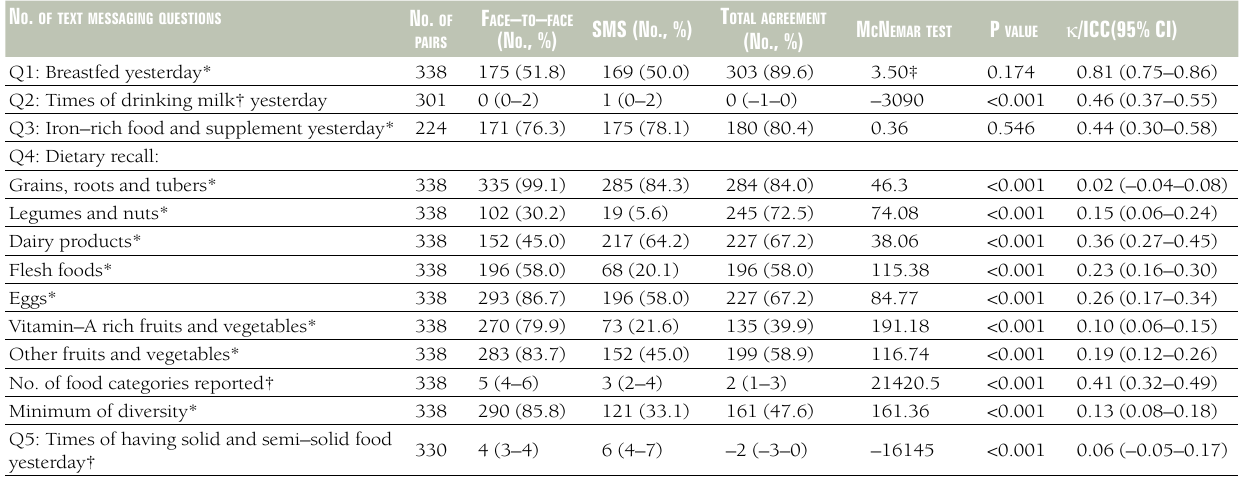
Table 2. Data agreement between the two methods N o . of TexT messagiNg quesTioNs